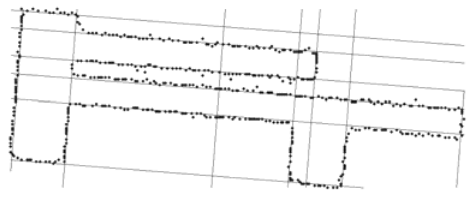
Figure 10. Lineaments by Hough transform